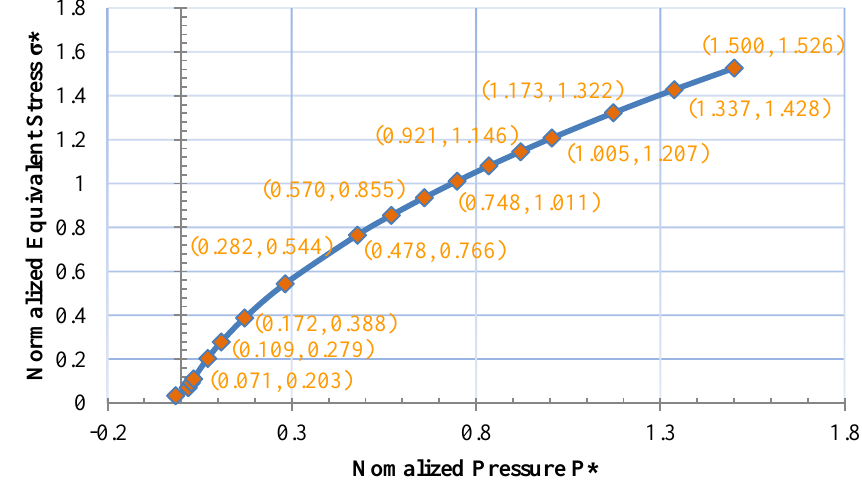
Figure 4. Calculated data and model for strength of Barre granite.